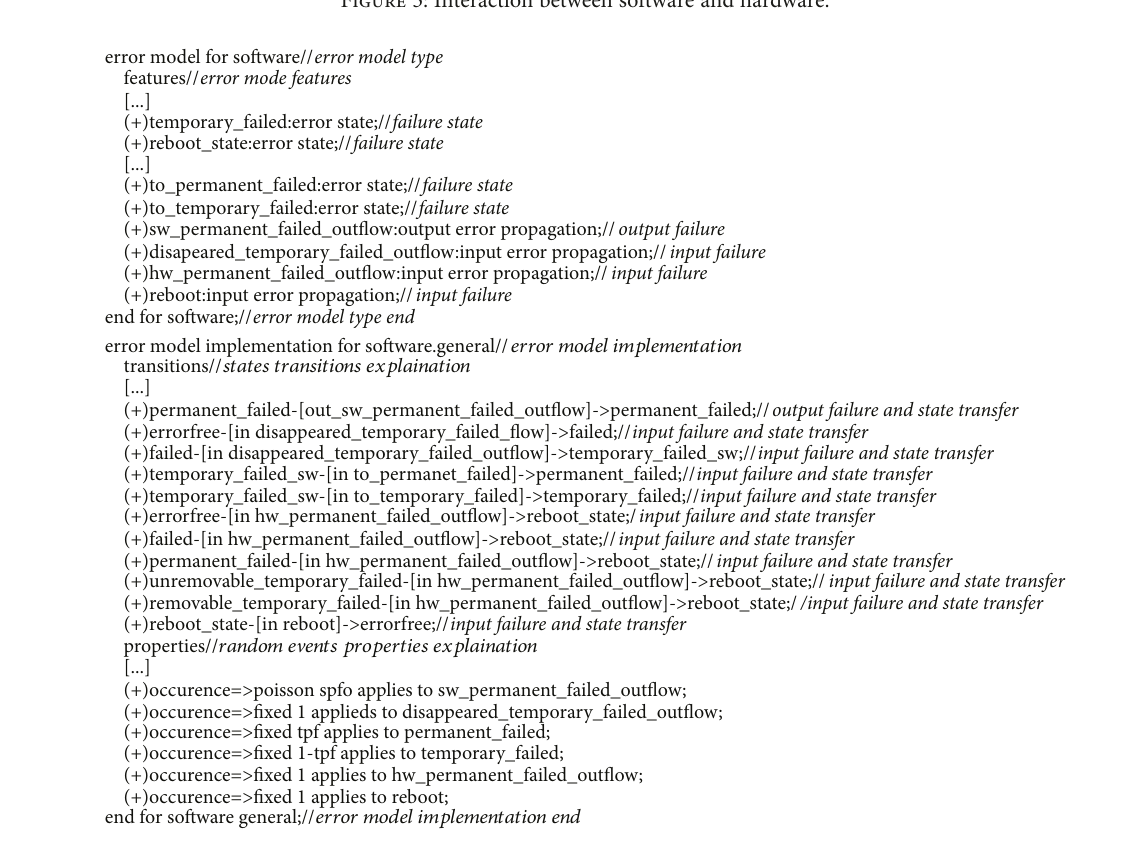
Figure 6: Error output and input model of